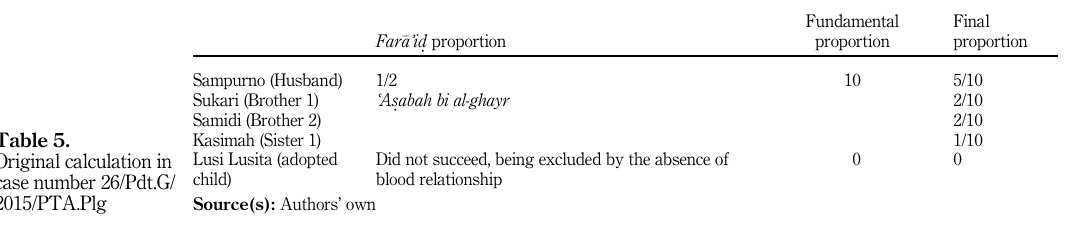
Table 5. Original calculation in case number 26/Pdt.G/